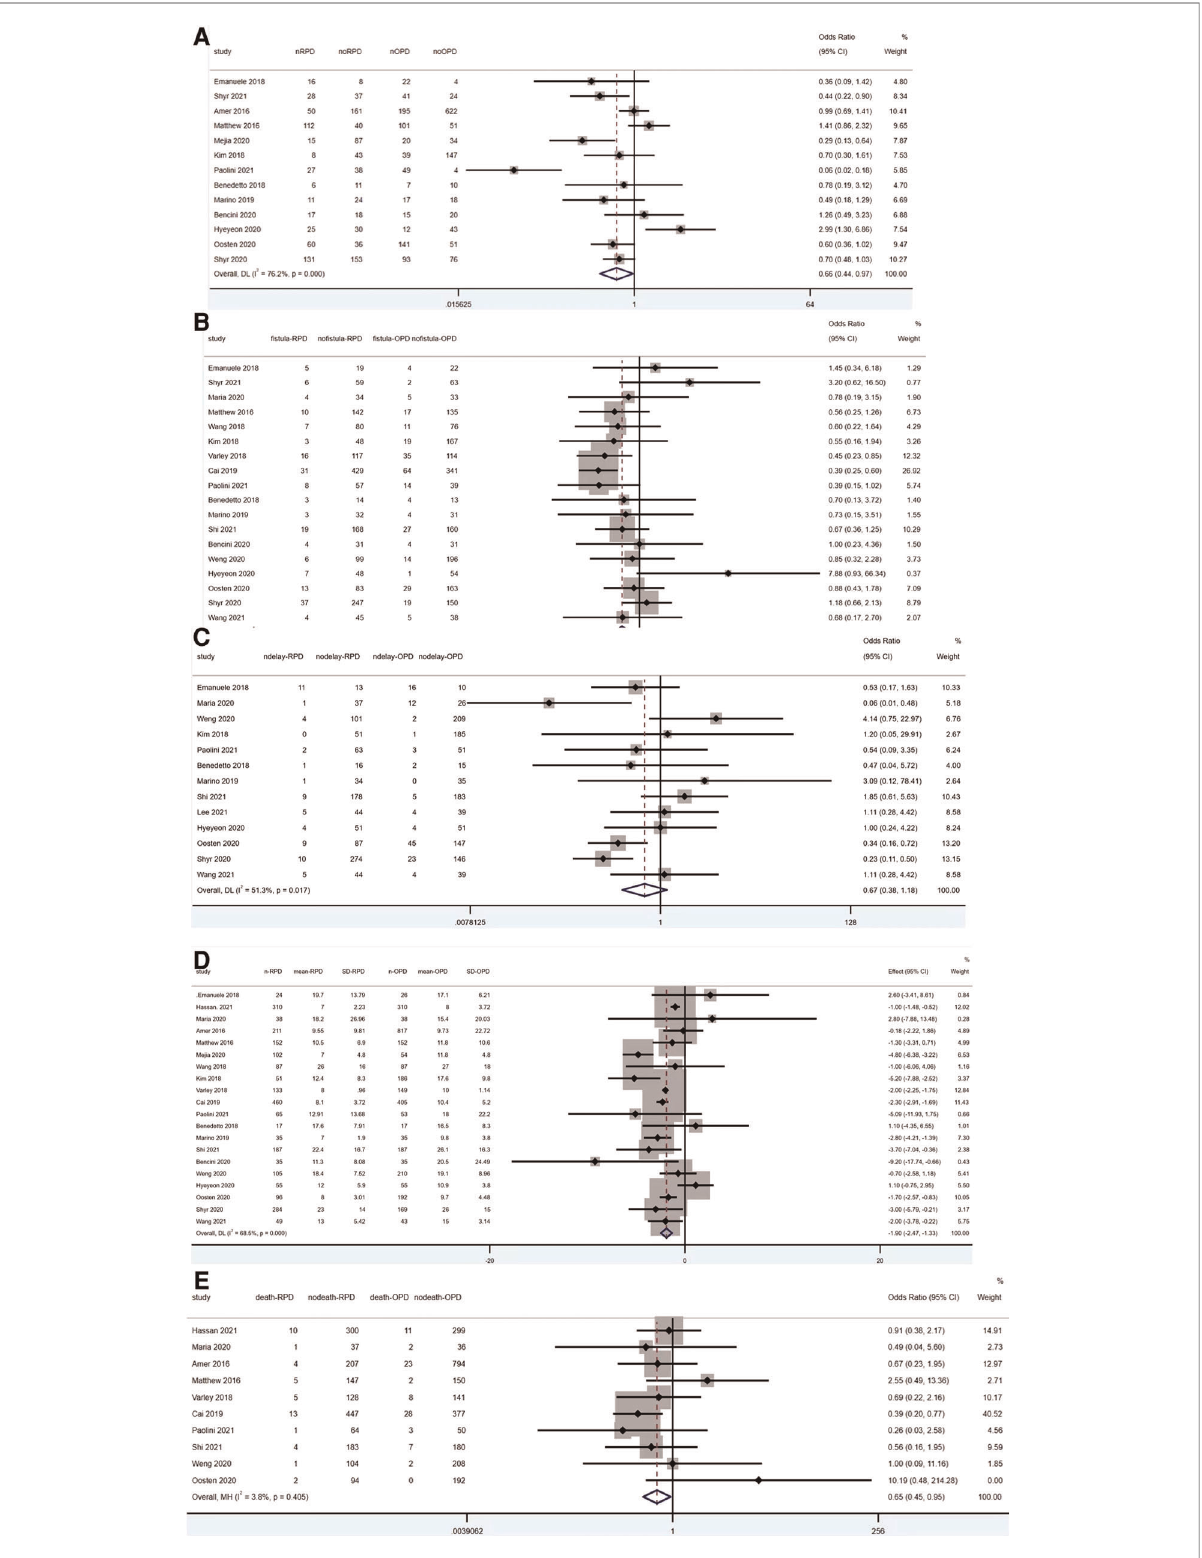
FIGURE 4 Meta-analysis of post-operative outcomes: ( A ) overall complication rates. ( B ) Pancreatic fi stula. ( C ) Delayed gastric emptying. ( D ) Length of stay. ( E ) 90-day